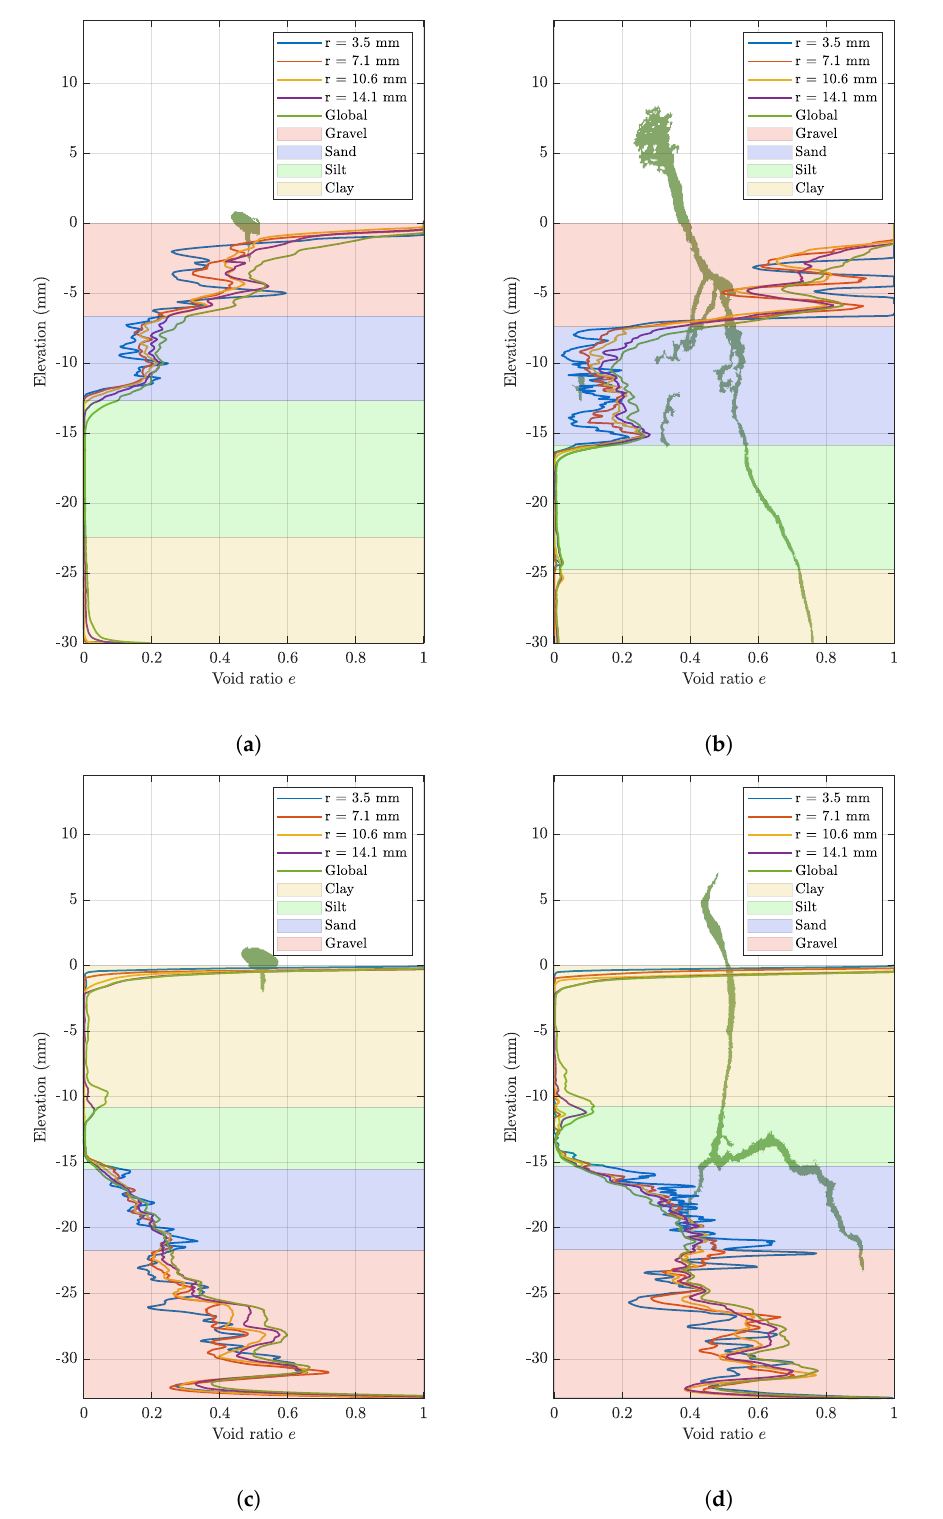
Figure 6. Void ratio profiles with elevation of ( a ) Sample A, day 1, ( b ) sample A, day 15, ( c ) sample B, day 1, and ( d ) sample B, day 15, using the 10% classifier (the layer thickness corresponds to averaged elevation for each